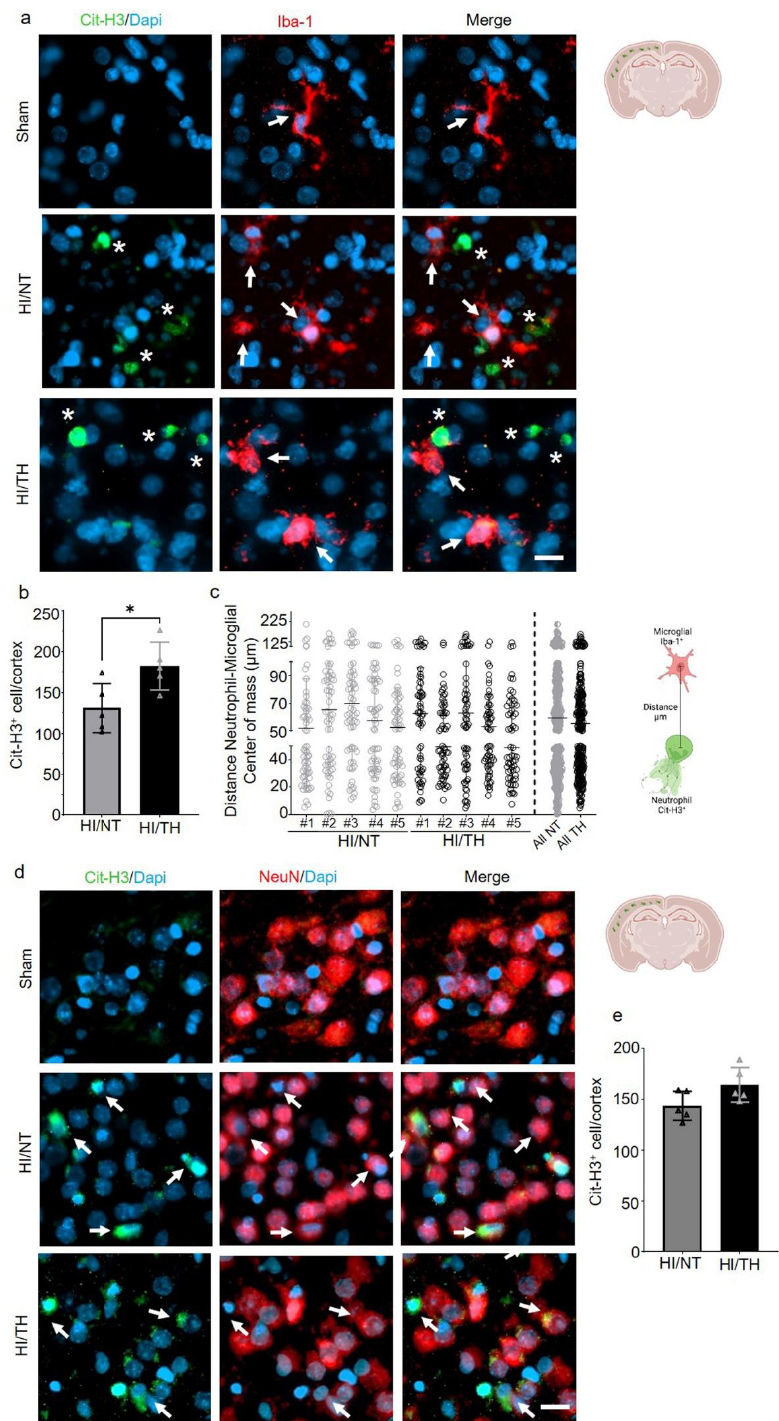
Figure 4. NETosis and its interactions with other cells in the brain after HI injury.